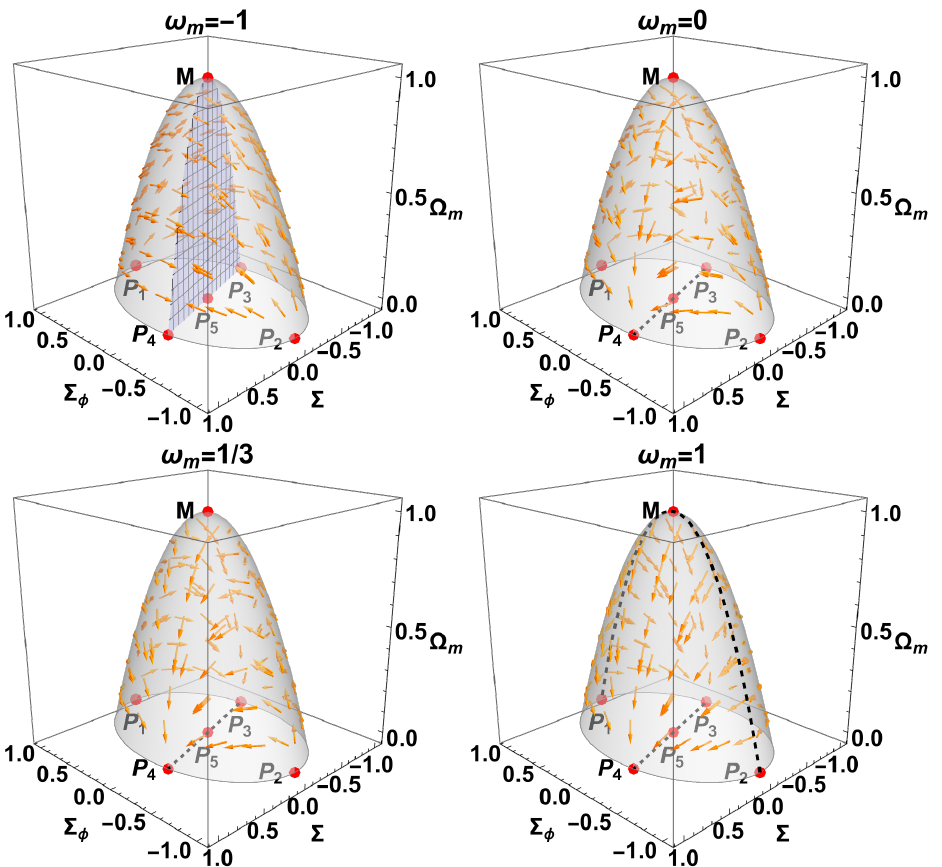
Figure 5. The 3D phase plot for System (82), (83), and (84) for (cid:101) = + 1, µ = 2, and different values of ω m